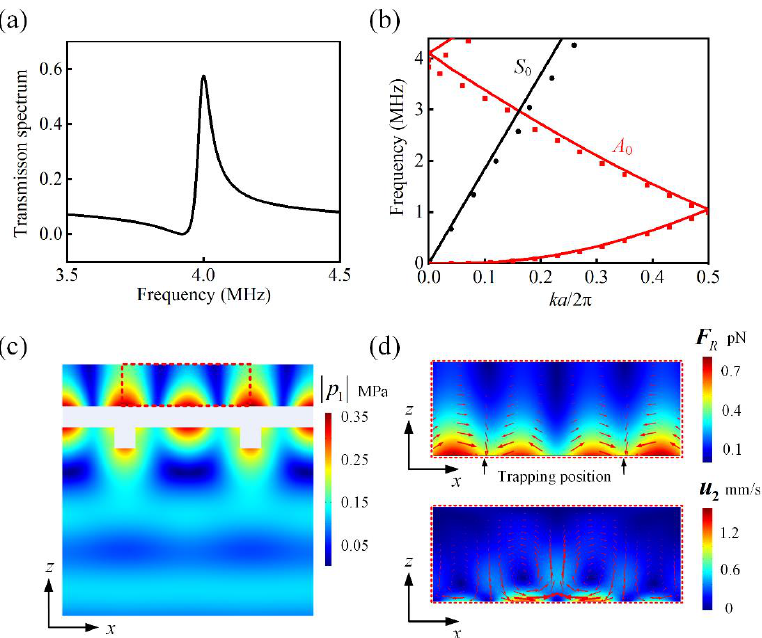
Figure 2. ( a ) Transmission spectrum of the PCP with t = 50 µ m, w = h = 50 µ m, and a = 300 µ m. ( b ) Numerical dispersion curves (black and red dots) for the PCP sample with a one-period structure. For comparison, the simply folded dispersion curves for the uniform plate are plotted as lines with the same color. Simulated amplitudes of the ( c ) first-order acoustic pressure and ( d ) acoustic radiation force 𝑭 𝑅 and velocity of AS 𝒖 𝟐 .